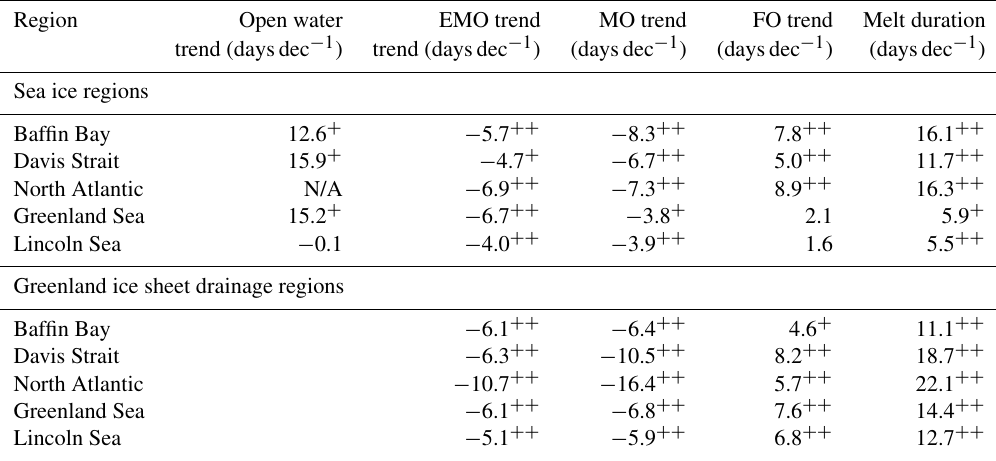
Table 2. Trends from 1979 to 2015 in length of open-water season, together with trends in melt onset, freeze-up, and melt season duration for five sea ice regions (excluding the North Atlantic, where little sea ice exists). Corresponding trends in melt onset, freeze-up, and duration are also shown for the Greenland drainage basins. Only values for the continuous melt onset and freeze-up periods are listed. Trends are given as days per decade. Statistical significance of trend at 95 and 99% are denoted by + and ++ , respectively. Region Open water EMO trend MO trend FO trend Melt duration trend (daysdec − 1 ) trend (daysdec − 1 ) (daysdec − 1